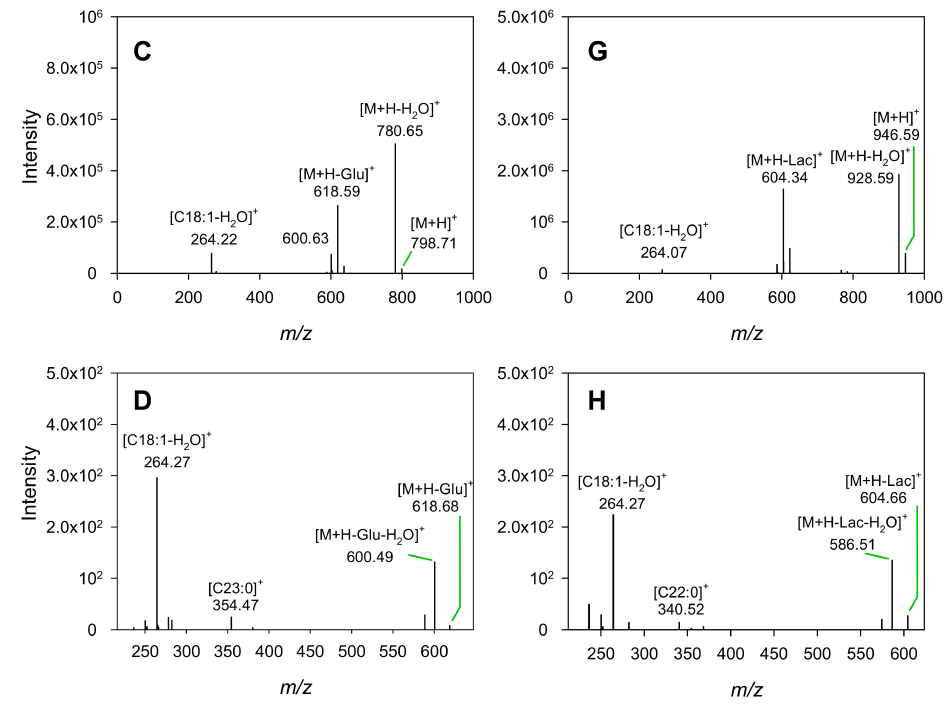
Figure 2. Typical mass spectra showing the total ion counts (TICs) of GluCer ( A ) and LacCer ( E ), commercial standards purified from buttermilk, separated using hydrophilic interaction liquid chromatography (HILIC) and detected in positive ion mode as protonated molecules. Corresponding mass spectra are presented in ( B ) and ( F ), respectively. The tandem mass spectrometry (MS 2 ) fragmentation of the GluCer m / z 798.71 amu ion ( C ) and the LacCer m / z 946.59 amu ion ( G ) are shown, followed by the corresponding three-stage mass spectrometry (MS 3 ) fragmentations of the daughter ions with m / z 618.68 amu ( D ) and m / z 604.66 amu ( H ),